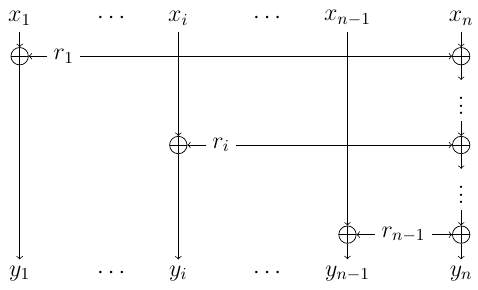
Figure 1: The RefreshMasks